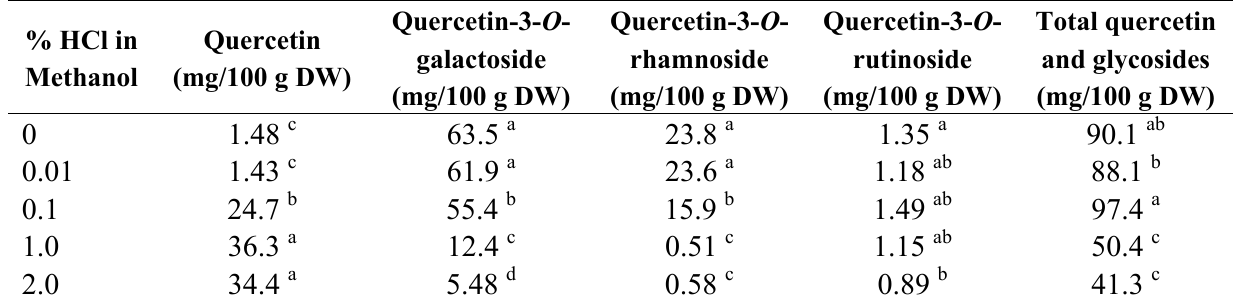
Table 2. Distribution of quercetin and selected quercetin glycosides in apple peel extracted with methanol containing various concentrations of hydrochloric acid a